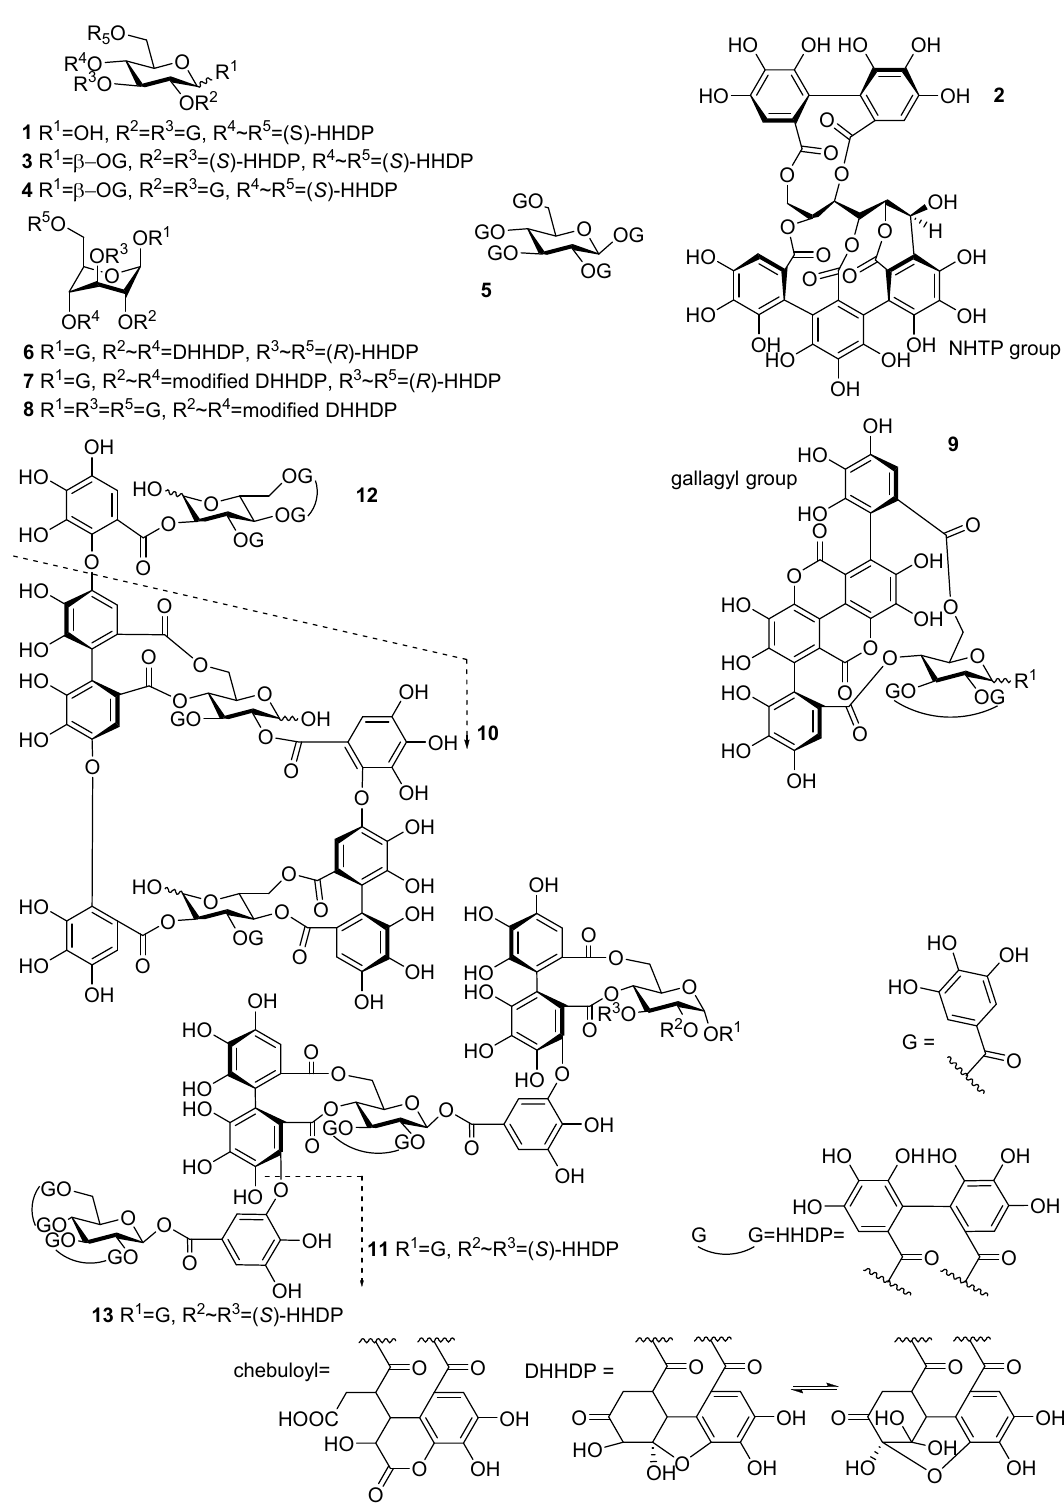
Figure 1. Chemical structures of 12 ellagitannins and pentagalloylglucose studied for their interaction with lipids: tellima- grandin I 1 , vescalagin 2 , casuarictin 3 , tellimagrandin II 4 , pentagalloylglucose 5 , geraniin 6 , chebulagic acid 7 , chebulinic acid 8 , punicalagin 9 , oenothein B 10 , sanguiin H-6 11 , oenothein A 12 , and lambertianin C 13 . DHHDP = dehydrohexahy- droxydiphenoyl, G = galloyl, HHDP = hexahydroxydiphenoyl, chebuloyl = modified dehydrohexahydroxydiphenoyl, NHTP = nonahydroxytriphenoyl.